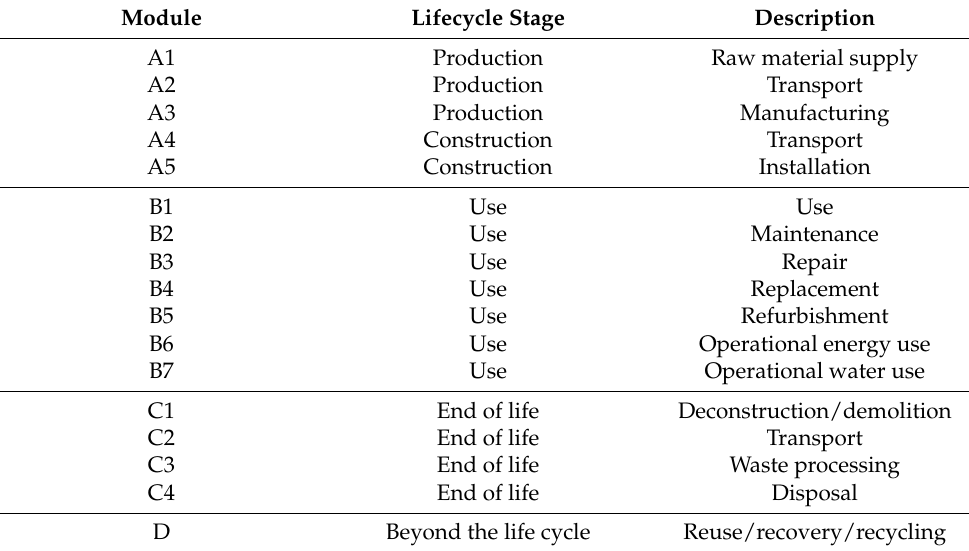
Table 1. Lifecycle stages divided into modules according to EN15804.